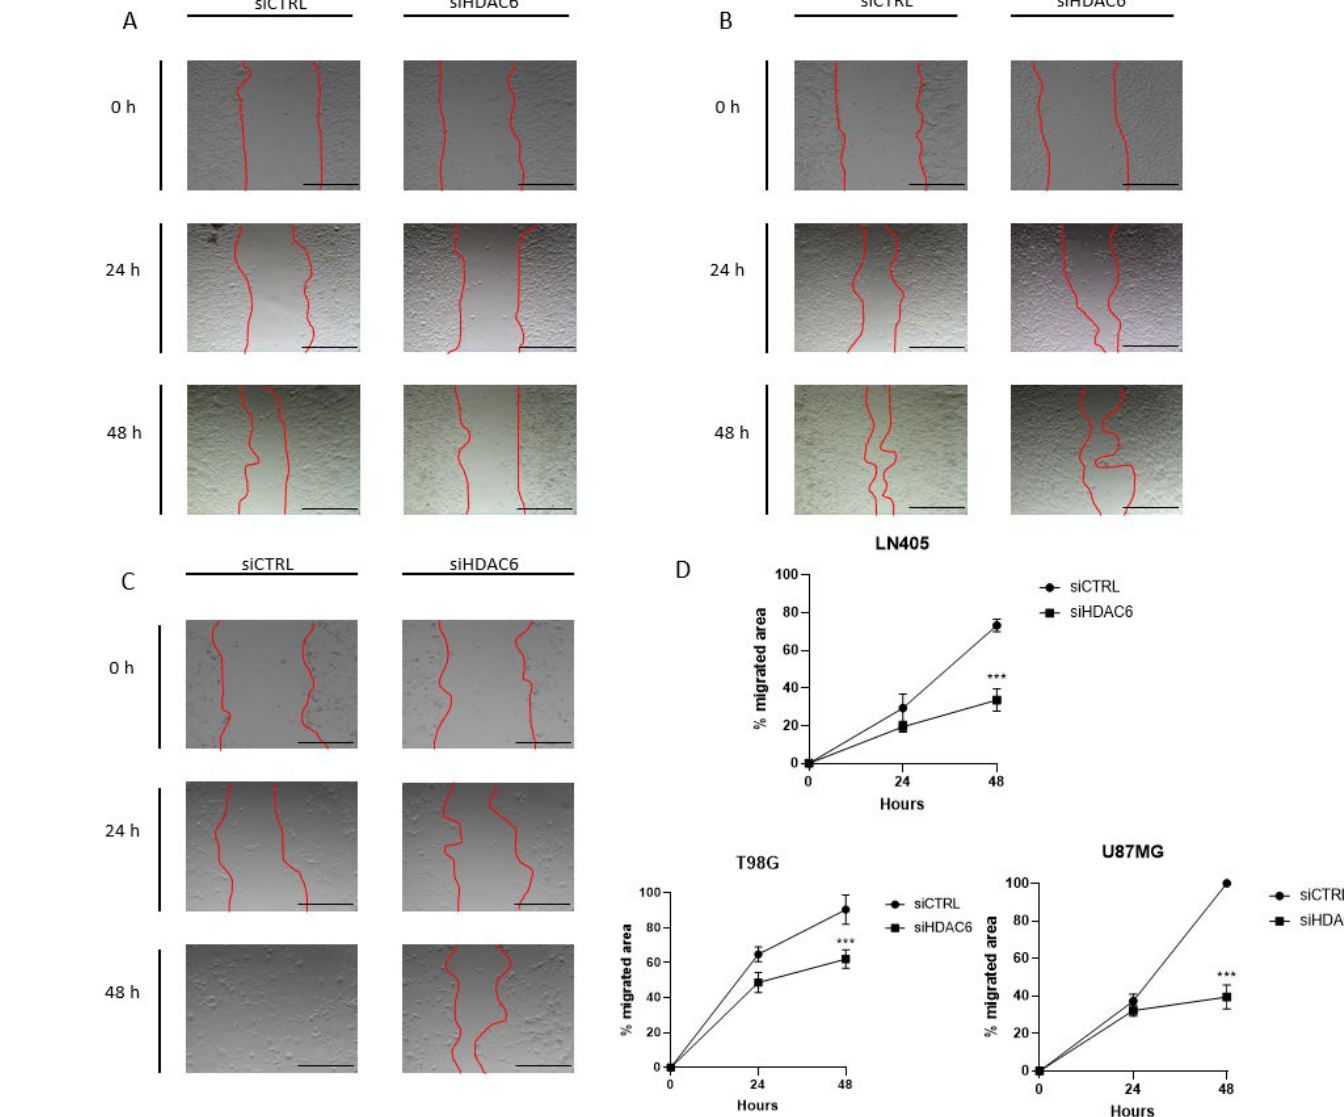
Figure 8. HDAC6 silencing inhibits the migration potential of GBM cell lines. ( A – C ) Representative images of wound healing assay at 0, 24, and 48 h post-scratch. The red bars represent the migration front in ( A ) LN405, ( B ) T98G, and ( C ) U87MG. ( D ) Analysis of wound closure assay. Scale bars drawn on the pictures correspond to 500 µm. Data are represented as mean ± SD. (***) p < 0.001 vs. siCTRL condition at same time ( n = 3 of three independent experiments).